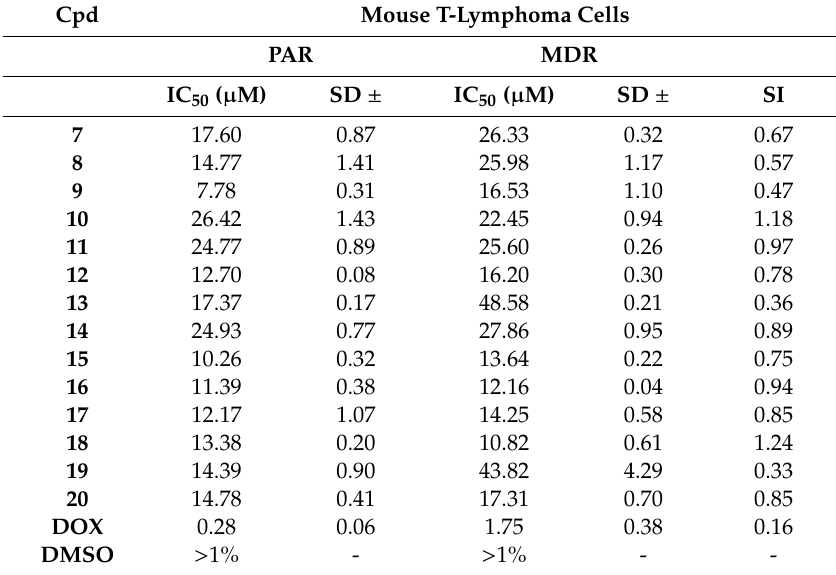
Table 4. Antiproliferative e ff ects of 2-amine-5-arylideneimidazolones ( 7 – 20 ) on cancer cells. Cpd Mouse T-Lymphoma Cells PAR MDR IC 50 ( µ M) SD